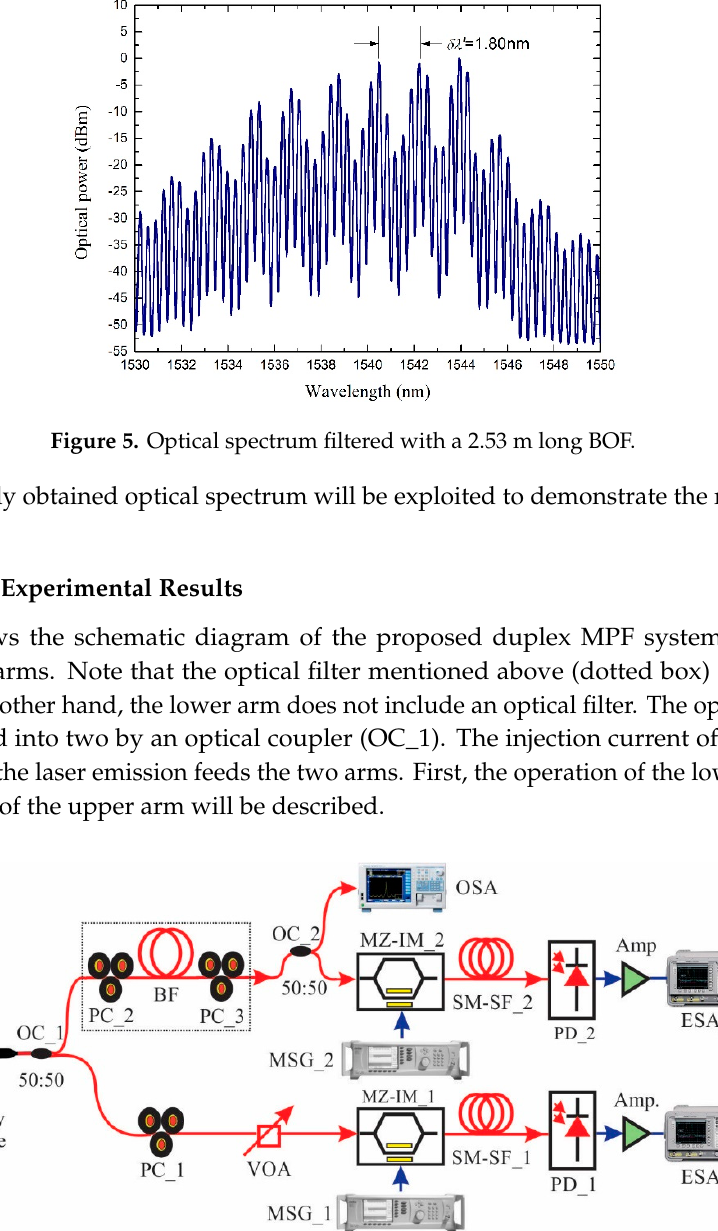
Figure 6. Schematic setup of the duplex Microwave Photonic Filter (MPF) system. MLD: multimode